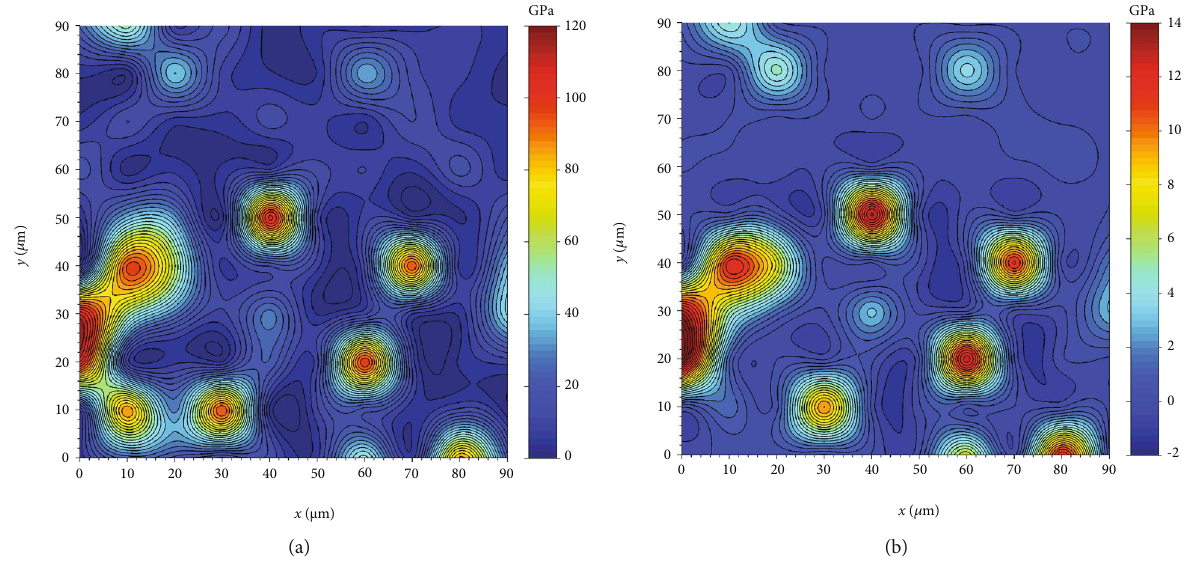
Figure 10: Distribution of (a) indentation modulus and (b) hardness in the tested region of specimen